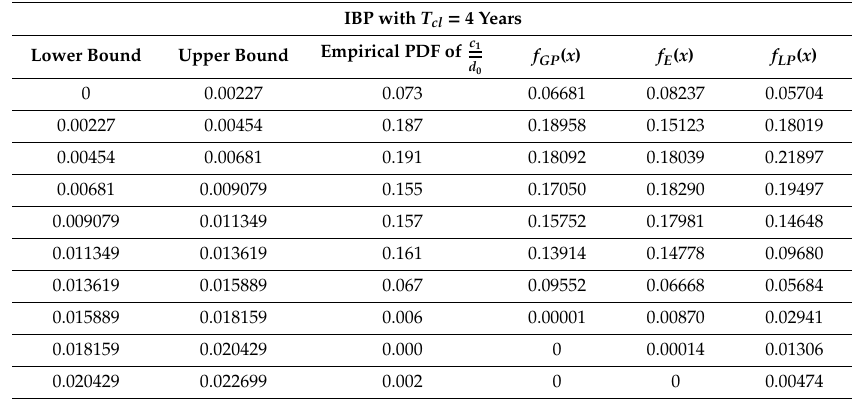
Table 5. The empirical values and the values of PDF for the three best fitted three-parameter distributions for c 1 with respect to IBP. d 0